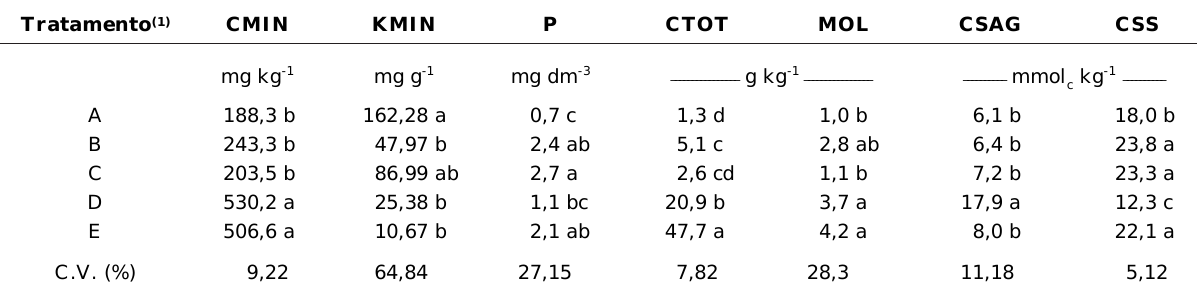
Quadro 2. Teores de carbono mineralizável (CMIN), taxa de carbono mineralizável (KMIN), fósforo disponível (P), carbono orgânico total (CTOT), matéria orgânica leve (MOL), carbono solúvel em água (CSAG) e carbono solúvel em solução salina (CSS), em função dos tratamentos